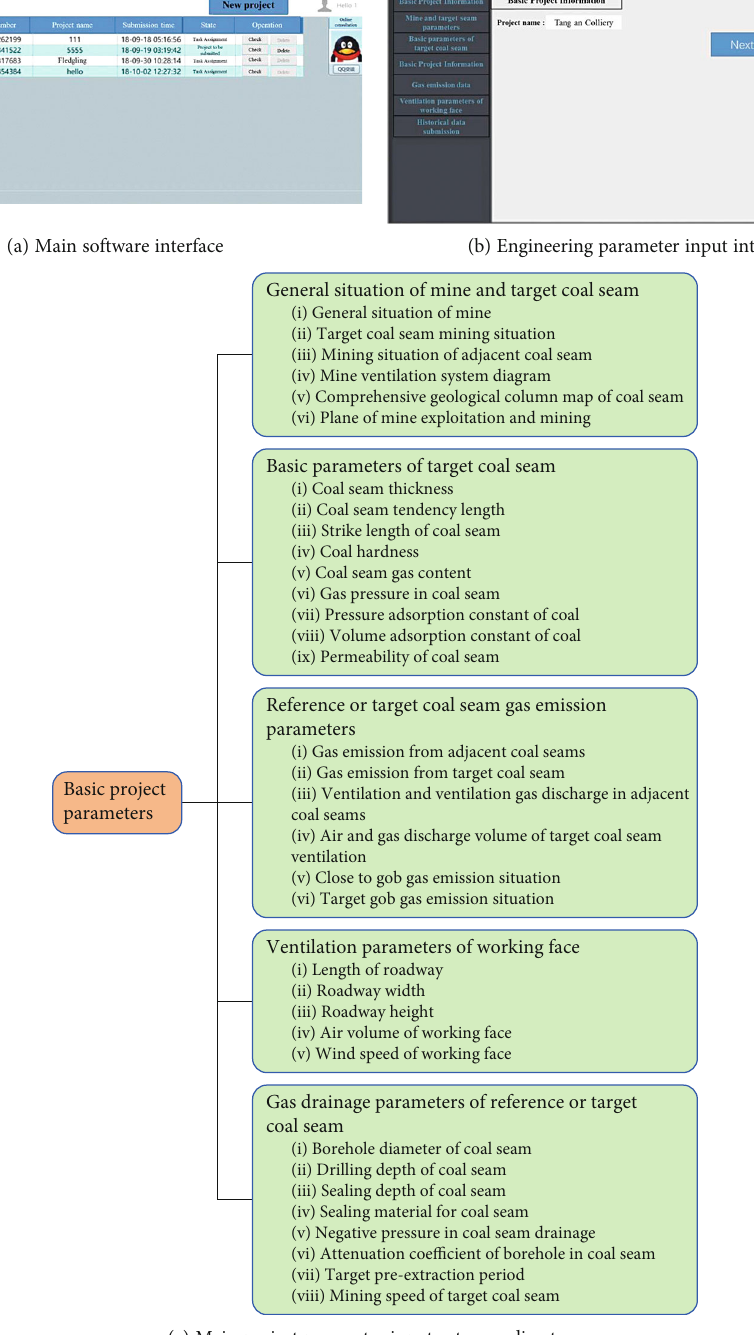
Figure 3: Design interface and main parameters of the service